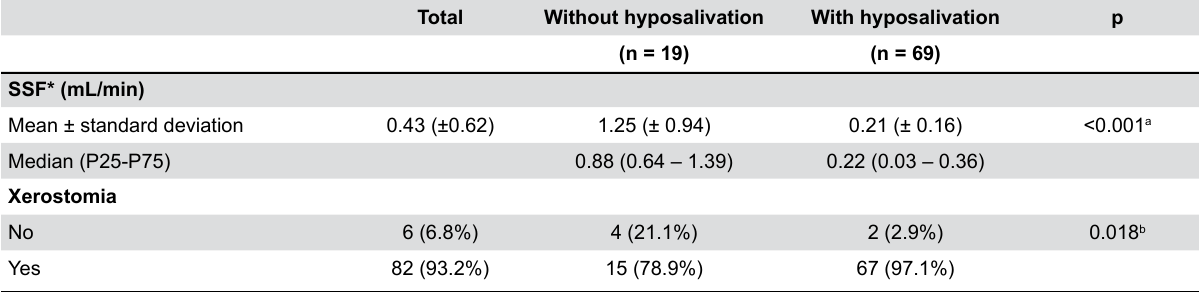
Table 2- Stimulated salivary flow rate (mL/min) and perception of xerostomia in patients with and without hyposalivation